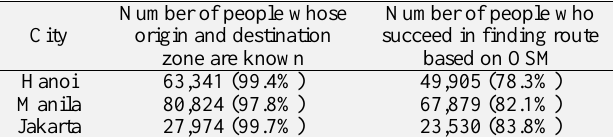
Table 2. Status of PT data cleaning